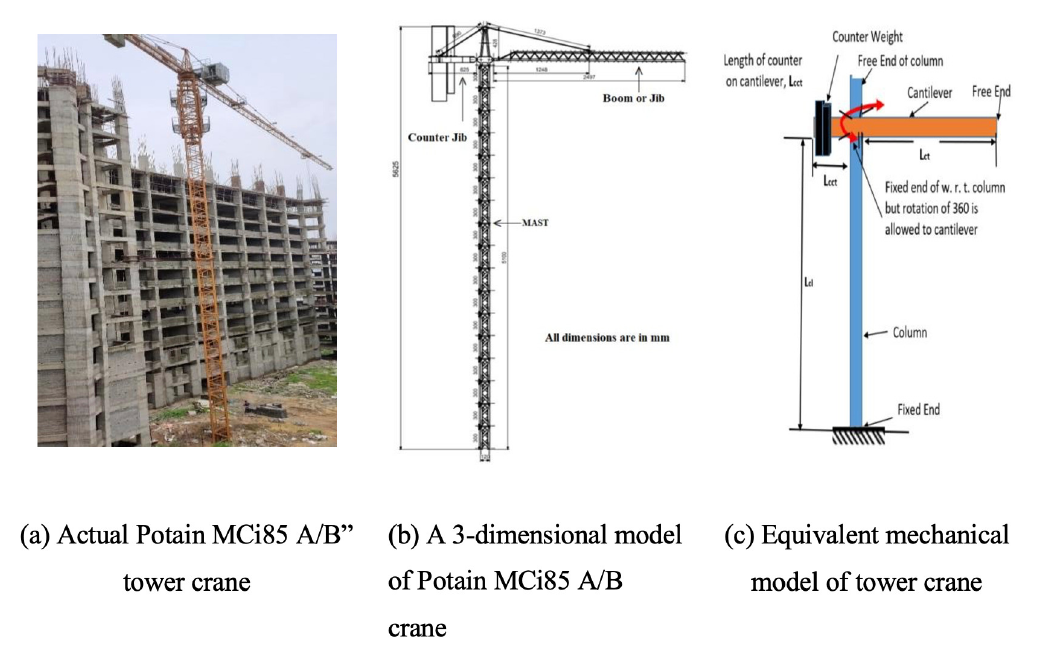
Figure 1. The Tower crane model considered for investigation and its equivalent model